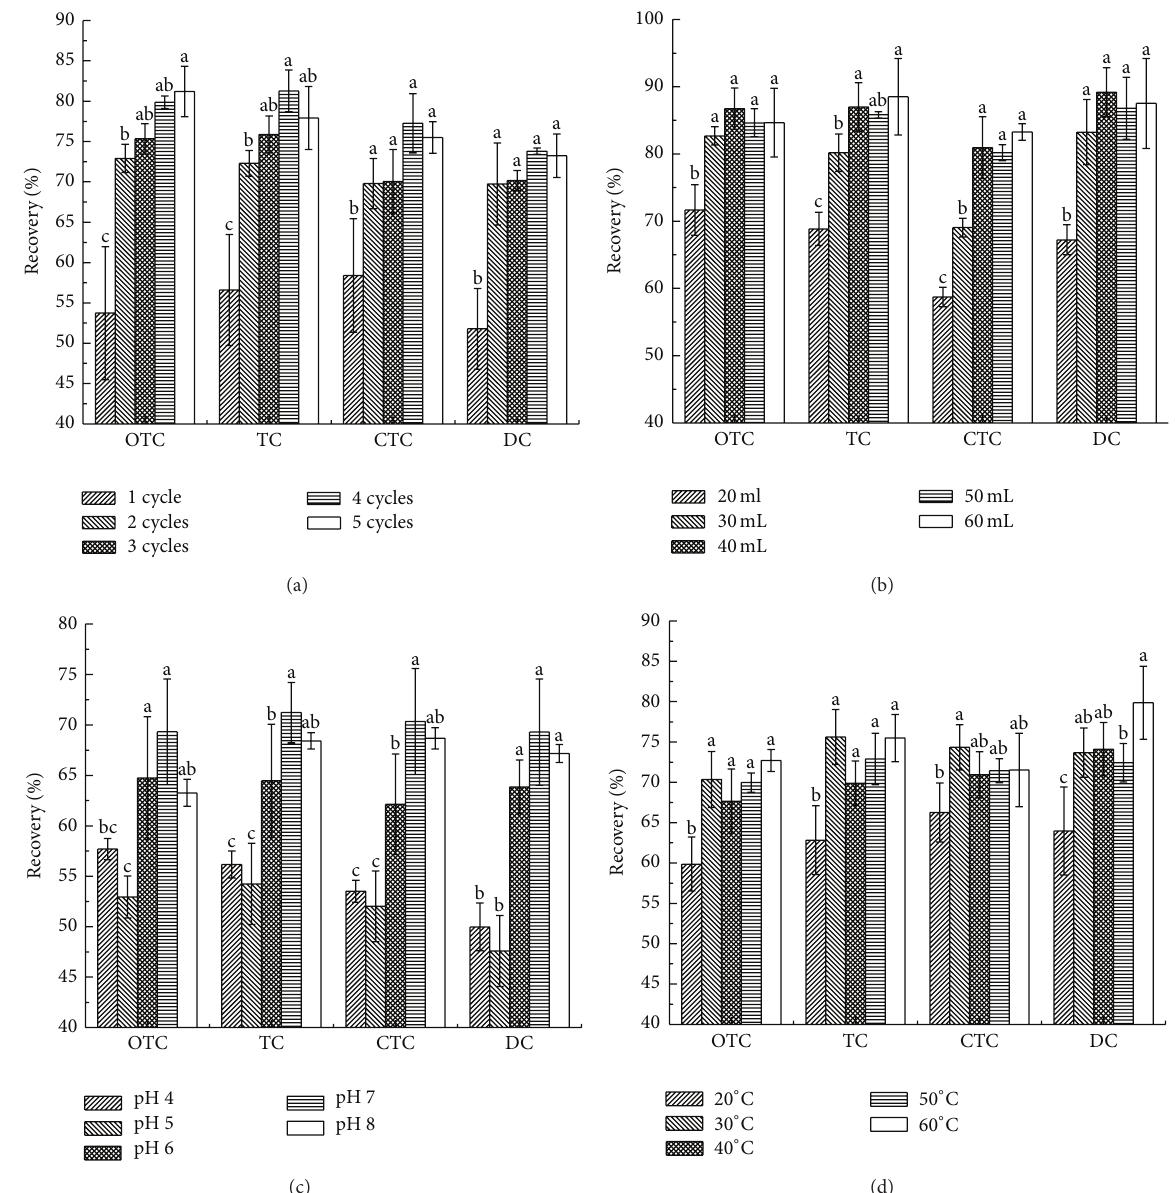
Figure 1: Effects of number of extraction cycles (a), solution volume (b), pH (c), and temperature (d) on OTC, TC, CTC, and DC extraction efficiency ( 𝑛 = 3